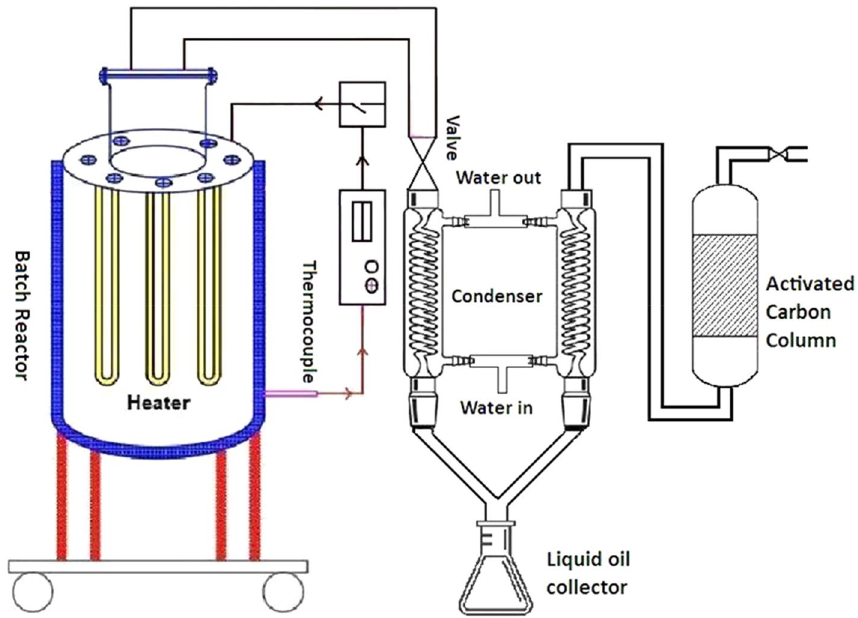
Figure 2. Experimental set up of thermal cracking of plastic based medical